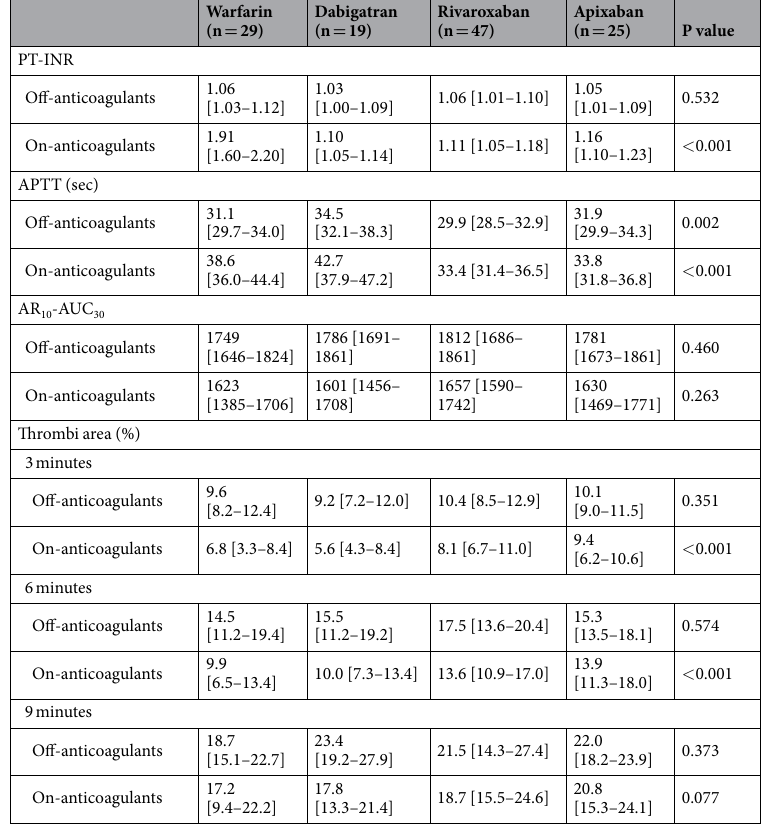
Table 2. PT-INR, APTT, and T-TAS parameters according to the type of anticoagulant. Data are median [25% to 75%]. P values are for differences among the four groups by Kruskal-Wallis